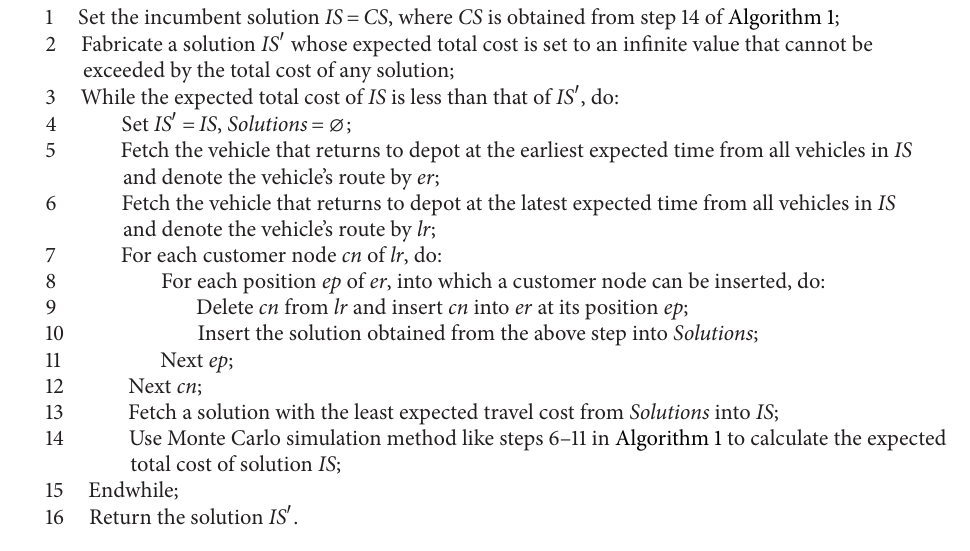
Algorithm 2: The method of improving a solution generated by a CVRP